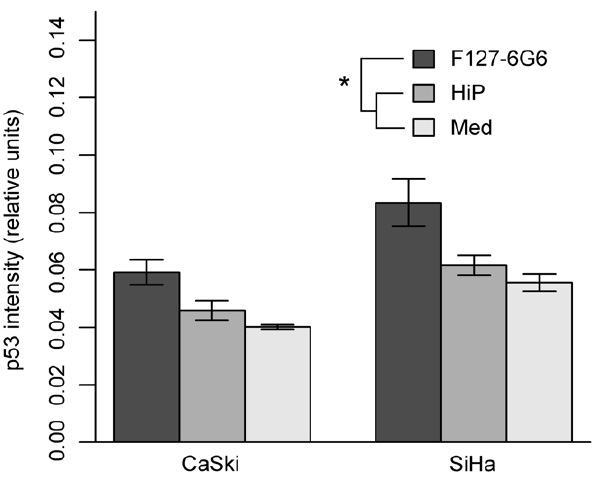
Figure 8. p53 positive NIKS cells (%) following chemical transfection with 4 m g/mL of HPV16 E6 antibodies. Neither antibody had an effect on the number of p53 positive NIKS cells ( P . 0.05, n= 3) after 48 hours. (HiP) Cells treated with only the HiPerFect transfection reagent. (Med) Cells receiving culture medium alone. Statistical analysis was performed using a one-way ANOVA. Error bars represent mean + / 2 SEM.